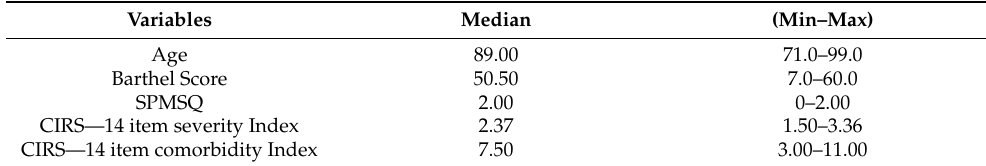
Table 3. Characteristics of the 20 residents vaccinated with the BNT162b2 vaccine